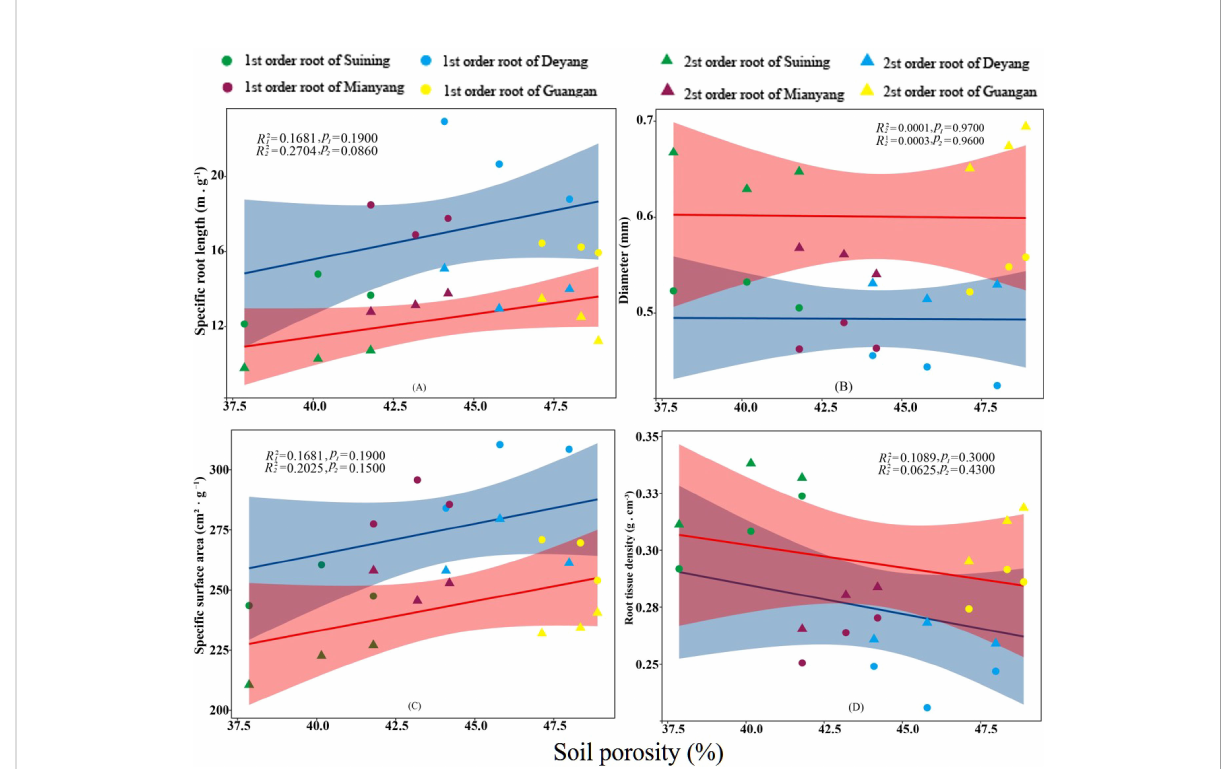
FIGURE 9 Effects of soil porosity on speci fi c root length, root diameter, speci fi c root surface area, and root tissue density at four research sites. R 12 and R 2 2 represent coef fi cients of determination for regressions of fi rst- and second-order fi ne roots * and ** indicate signi fi cance at p < 0.05 and p < 0.01, respectively. p 1 and p 2 are p-values indicating signi fi cance of regressions with fi rst- and second-order fi ne roots, respectively. The shaded part is the con fi dence interval of the fi tting line, regimes (n = 3 per